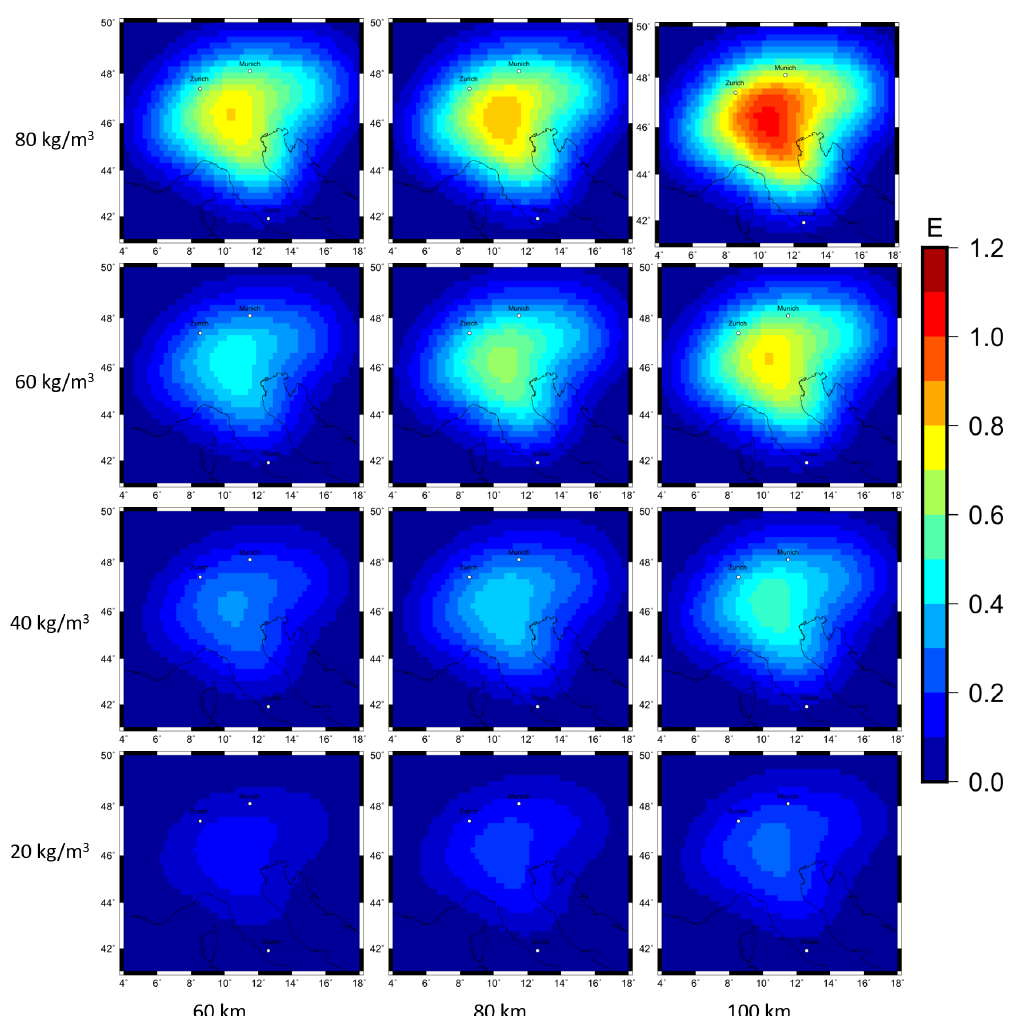
Figure A4. Forward-calculated gzz gravity signal for 12 different combinations of density contrast and slab thickness at a station height of 225km for subcrustal slab Configuration